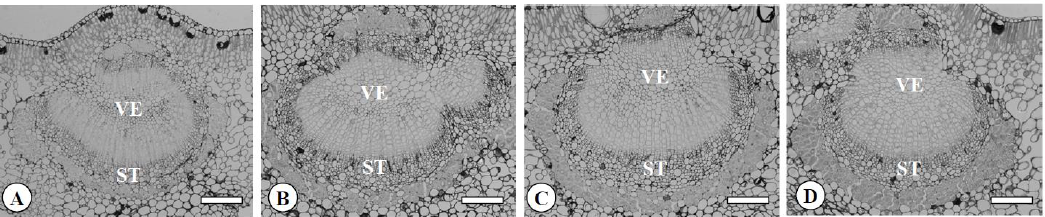
Figure 5. Transversal sections of midribs in the diploid ( A ), the tetraploid ( B ), the Yubeni ( C ), and the chimera ( D ) of the Meiwa kumquat. Bars = 100 µ m. VE: Vessel, ST: Sieve tube.